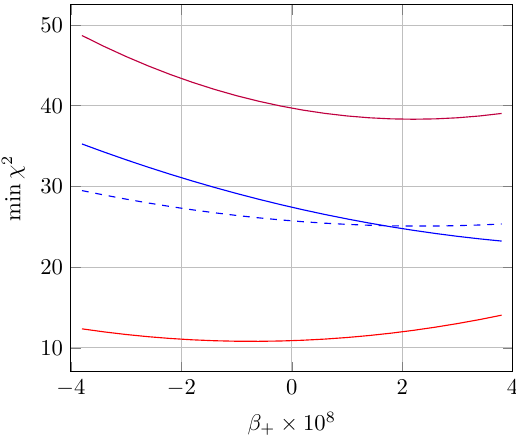
Figure 4 . The evolution of the minimum value of the (cid:31) 2 function with (cid:12) electron mode collected (from bottom to top) by BNL-E865 [55], by NA48/2 [56], and for the combination of the two sets. In the case of ref. [56], the minimum of the (cid:31) 2 function corresponding to the positive solution for a + and b + is also shown (dashed